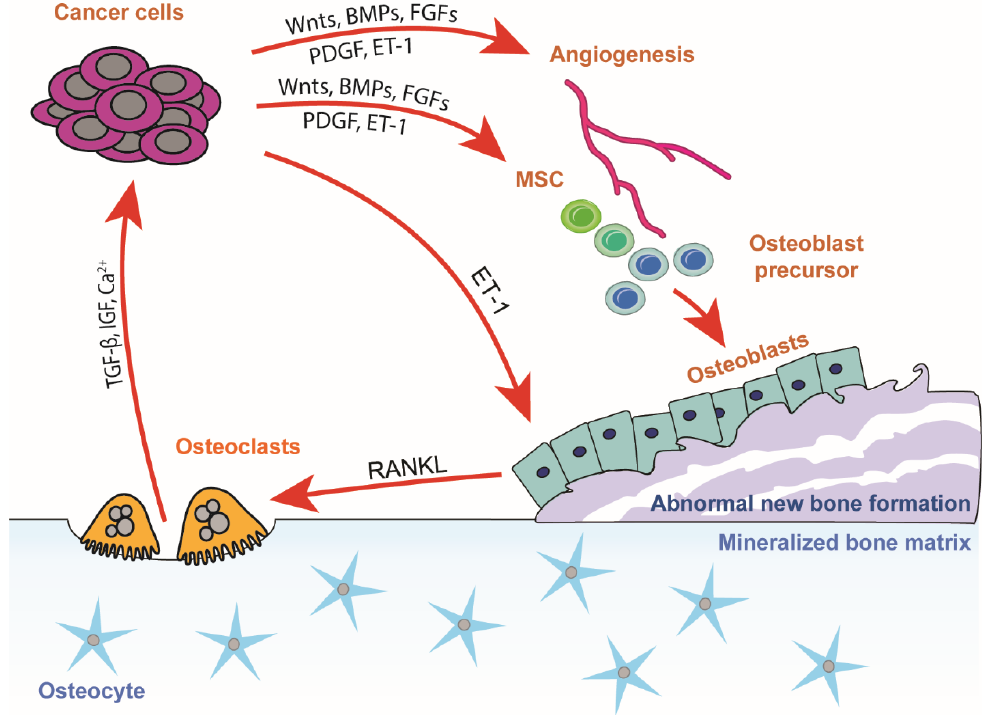
Figure 2. The vicious cycle of osteoblastic bone metastasis. In the vicious cycle of osteoblastic bone metastasis, cancer cells secrete factors that induce angiogenesis and differentiation of MSCs to osteoblasts. Cancer cells utilize the perivascular niches offered by the sprouting endothelium. Osteoblasts induce differentiation and activation of osteoclasts, and growth factors released by bone resorption support the growth of tumor cells. Abbreviations: BMPs: bone morphogenetic proteins, FGFs: fibroblast growth factors, MSC: mesenchymal stem cell, PDGF: platelet-derived growth factor, ET-1: endothelin 1, TGF- β : transforming growth factor β , IGF: insulin-like growth